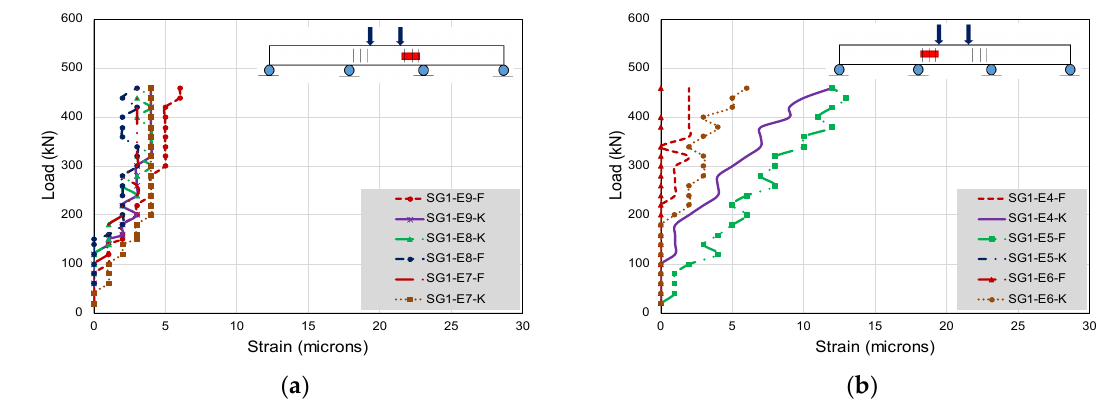
Figure 25. Load versus strain responses in load setup SP-1-L02 ( a ) E7–E9 and ( b ) E4–E6. Loading Setup SP-1-L03 Under this loading setup, four-point loading was applied to interior and left exterior spans up to the service limit. The recorded strain data are plotted in Figure 26. Due to the damage to strain gages D2, D3, E1, and E3, only data for strain gages D1 and E3 are plotted in Figure 26a,b, respectively. Maximum strains recorded at D1–D3, E1–E3, E4–E6, and E7–E9 were limited to 590, 5, 15, and 7 microns, respectively. It is evident that the exterior span was shear critical, as negligible stirrup strains were recorded within the interior span under a four-point service load.